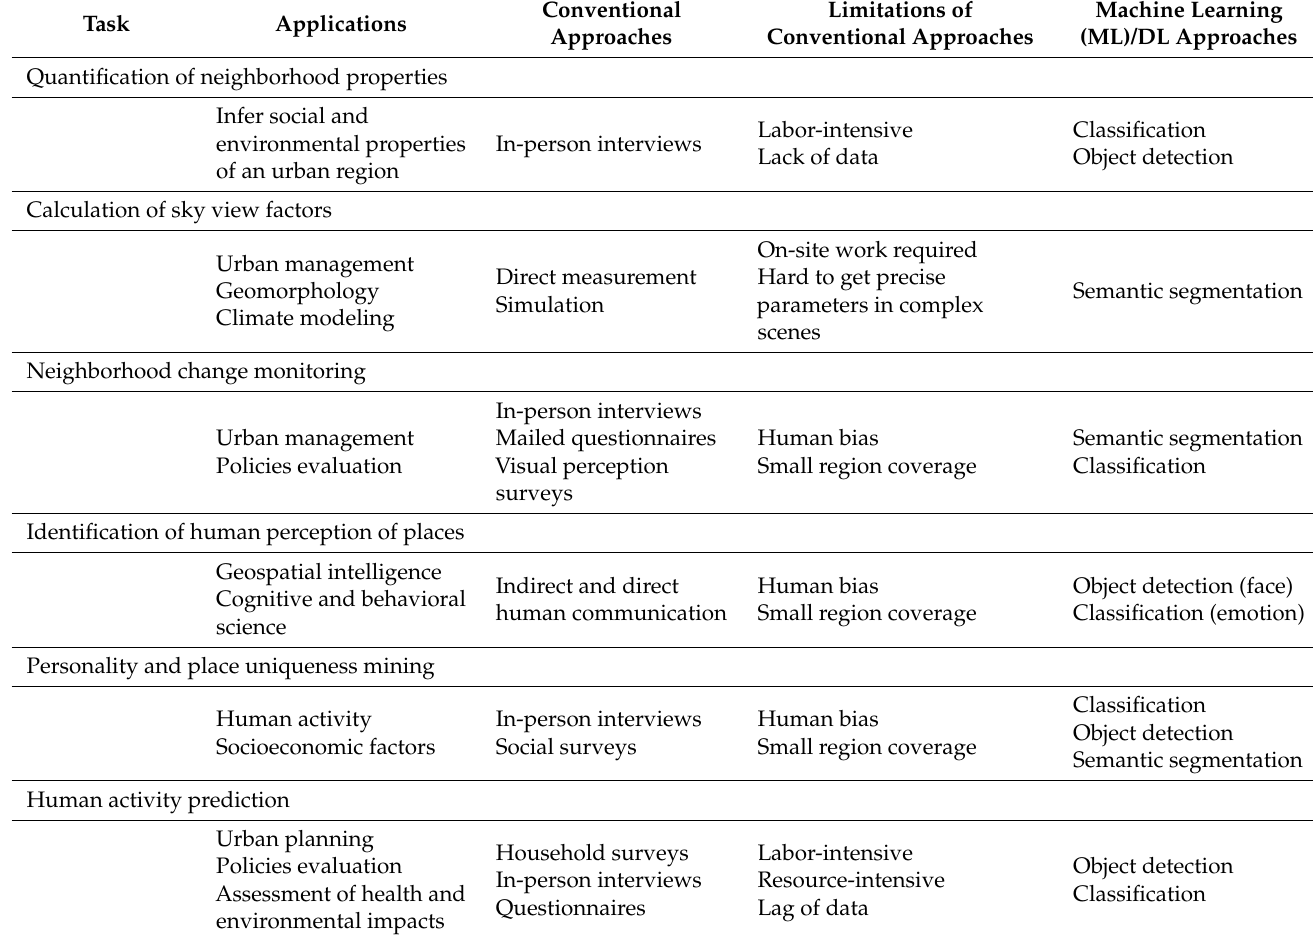
Table 2. Summary of GeoAI and deep learning applications in street view image